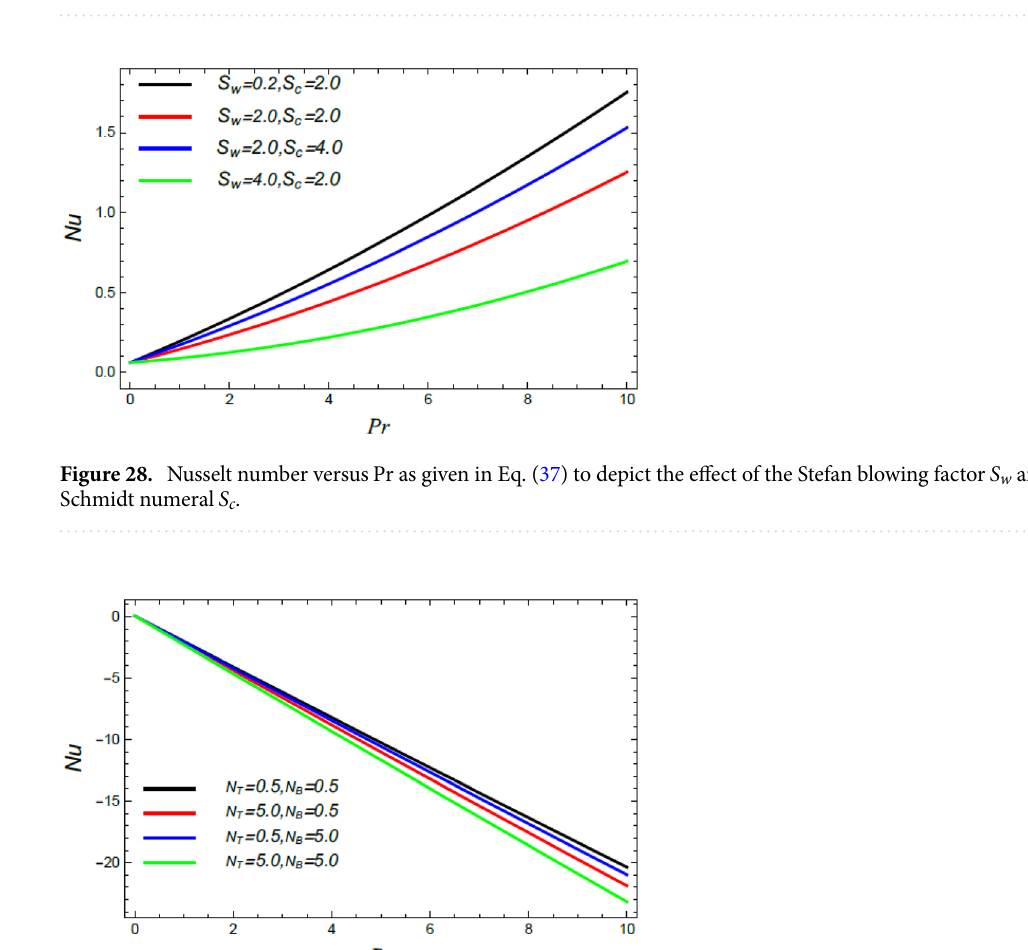
Figure 27. Skin friction coefficient versus M as given in Eq. (36) to illustrate the impact of the stretching factor α and the material factor K .